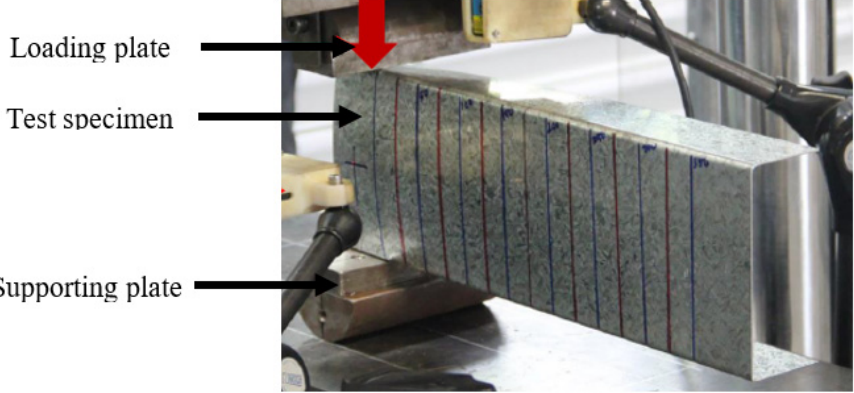
Figure 2. Experimental set-up for ETF load case [21].